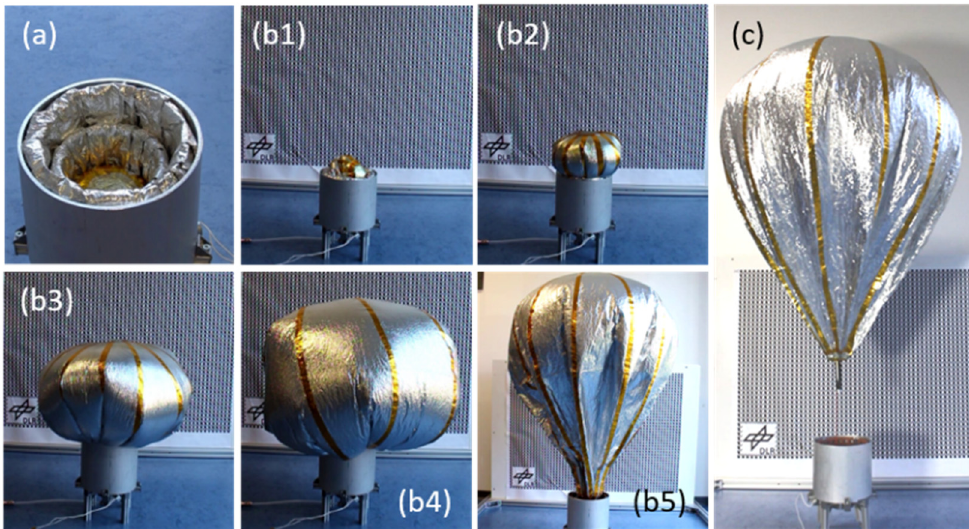
Figure 7. A 3.25 m test sphere in DLR’s Landing and Mobility Test Facility.